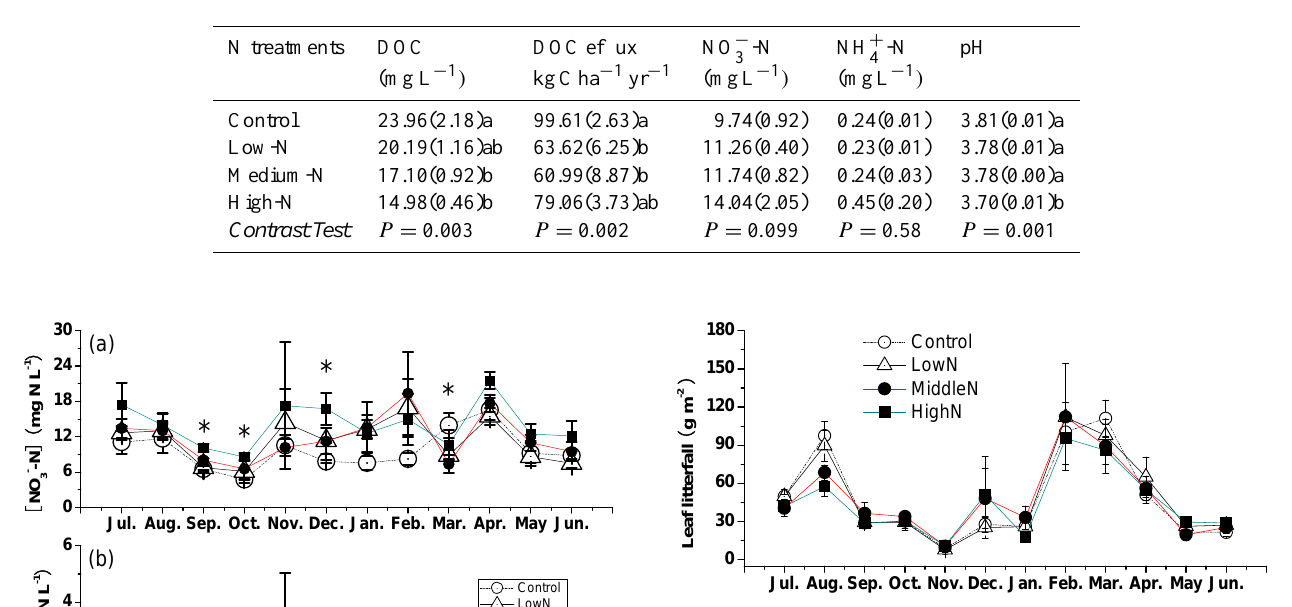
Table 1. Effects of N addition on average concentrations of DOC, NO − -N, NH + -N, and pH, and annual DOC efflux in soil solutions below 3 4 the primary rooting zones (0–20cm soils) during the periods from July 2009 to June 2010. The different lowercase letters indicate significant differences at P < 0 . 05 level, and no letters indicate no significant differences among N treatment levels, respectively (Tukey’s HSD test); Contrast Test is conducted between N treatments and the Controls using planned contrast analysis. Values are mean with SE in parentheses.